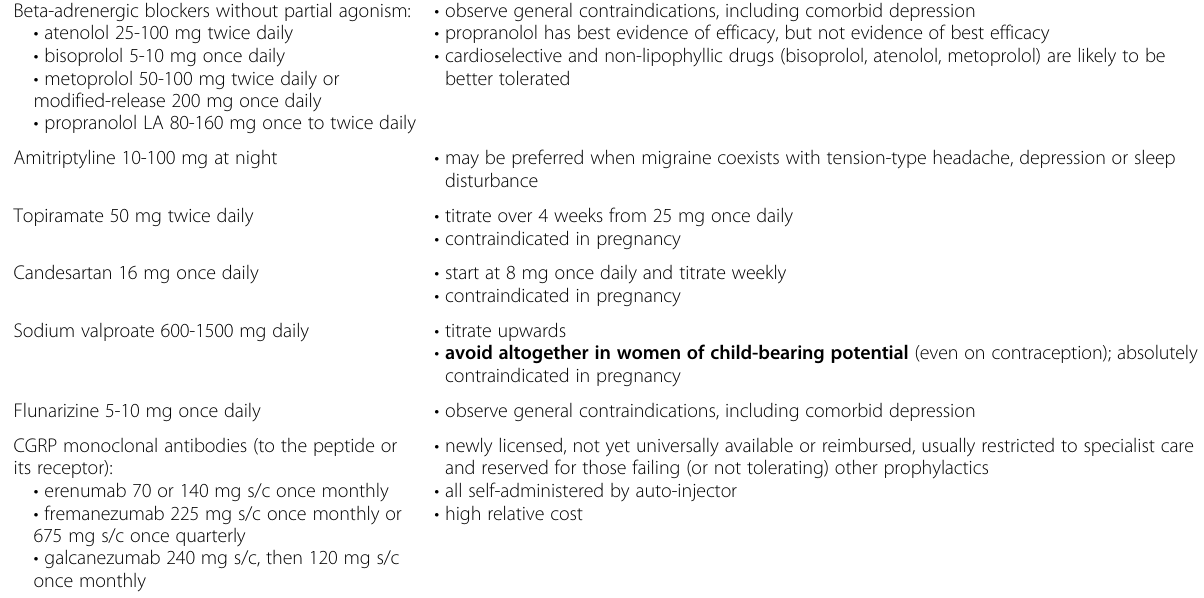
Table 9 Migraine prophylactic drugs with evidence of efficacy in adults (drugs are listed in a suggested order of use; within classes [beta blockers and CGRP monoclonal antibodies], they are listed alphabetically) Beta-adrenergic blockers without partial agonism: (cid:129) atenolol 25-100 mg twice